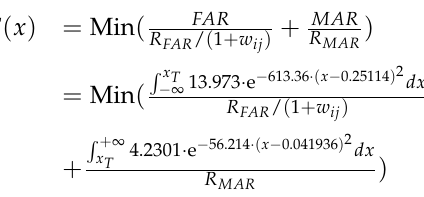
Eventually, the objective function is optimized as Figure 6, with optimum x T = 0.22, F ( x T ) = 6.5098, FAR = 0.00654, MAR = 0.06710. The thresholds of other variables are optimized